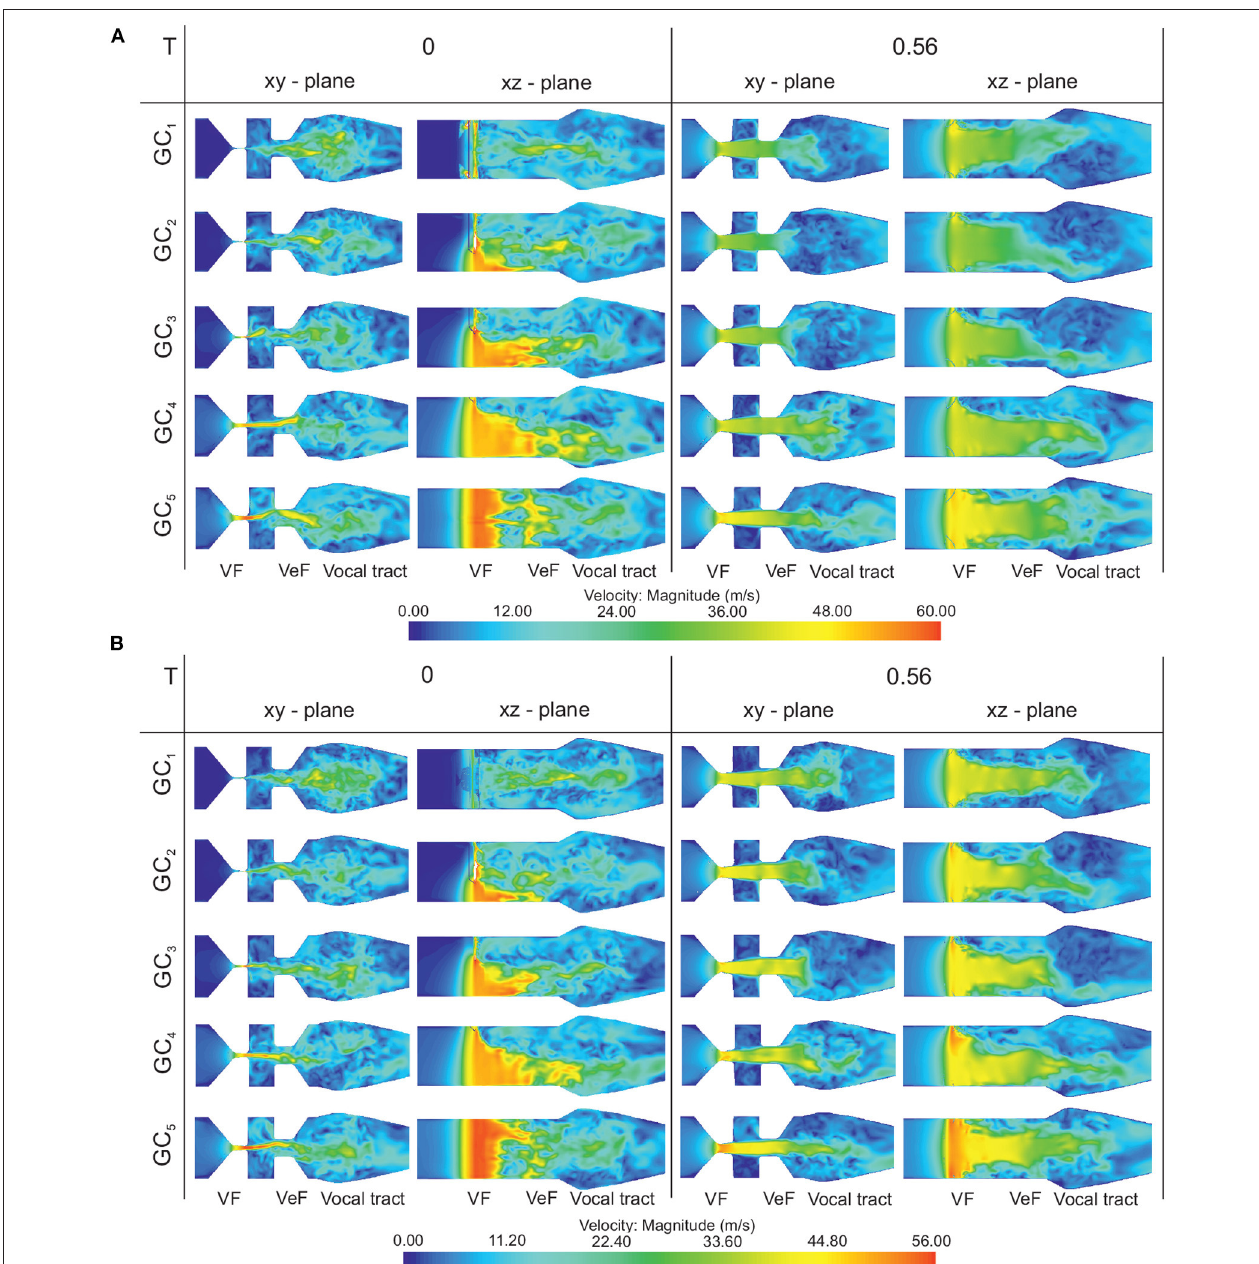
FIGURE 8 | (A) Symmetric vocal fold motion: velocity magnitude in the midcoronal (xy-plane) and the sagittal (xz-plane) plane for the five GC types at two instances ( t 1 = 0 and t 2 = 0.56 T ) of an oscillation cycle. While GC1 fully interrupts the glottal jet at the end of the cycle, GC2 and GC3 only partly, and GC4 and GC5 do not interrupt the laryngeal fluid flow. (B) Asymmetric vocal fold motion: Velocity magnitude in the midcoronal (xy-plane) and the sagittal (xz-plane) plane for the five GC types at two instances ( t 1 = 0 and t 2 = 0.56 T ) of an oscillation cycle. The upper vocal fold moves with the 50 % amplitude and the glottal jet impinges mainly the lower VeF and subsequently, just a vortex in the lower ventricle occurs.